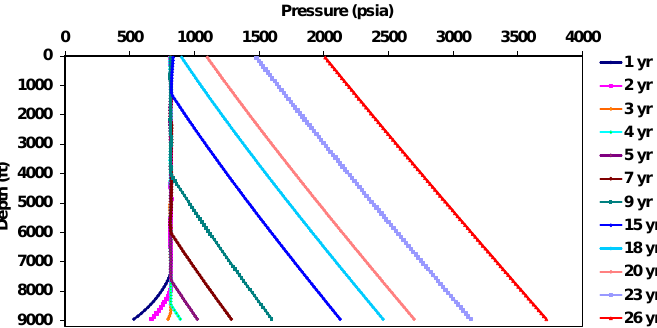
Figure 13. CO 2 pressure in the wellbore vs. depth shown at different times. The unstable two-phase region disappears after 18 years of injection as the pressure throughout the entire wellbore exceeds the CO 2 bubble-point pressure. The corresponding densities are plotted